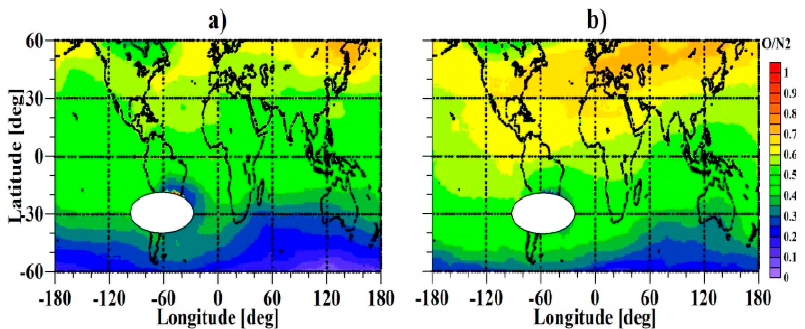
Figure 13. ( a ) Distribution of O/N 2 ratio on 31 January 2022 and ( b ) medians calculated for the period 29 January 2022 − 16 February 2022.